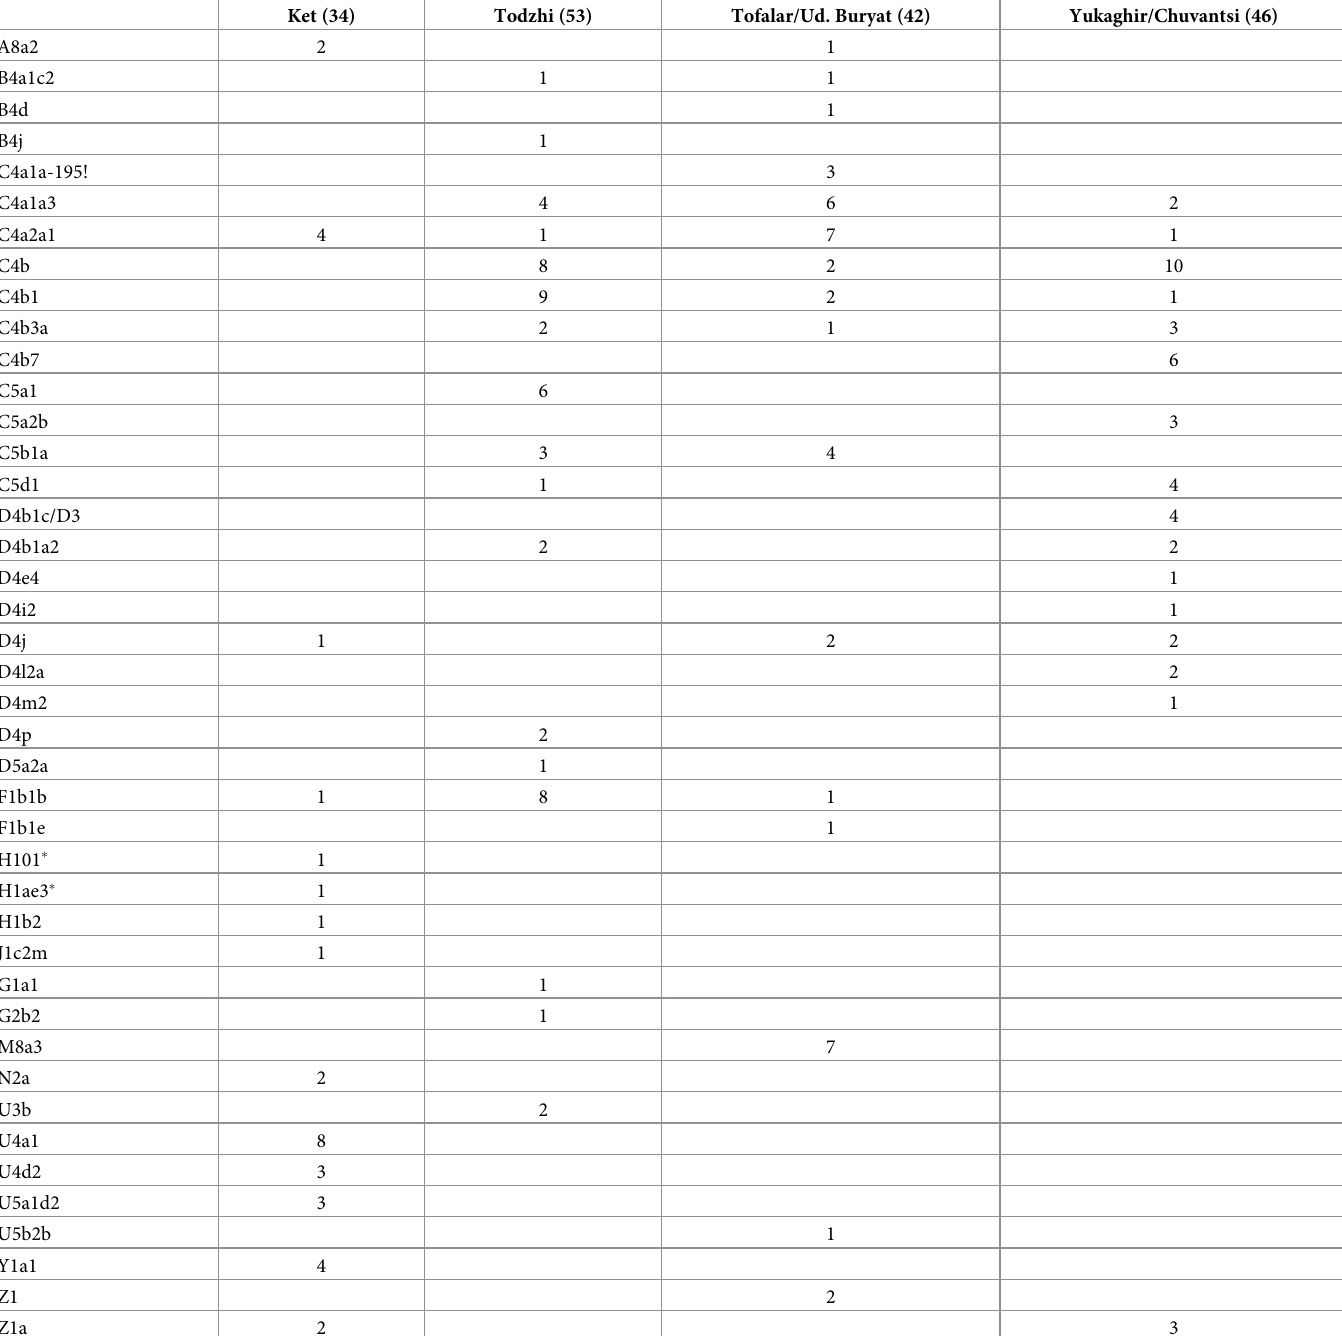
Table 1. List of mtDNA (sub)haplogroups found in the dataset and their frequencies in four populations. Ket